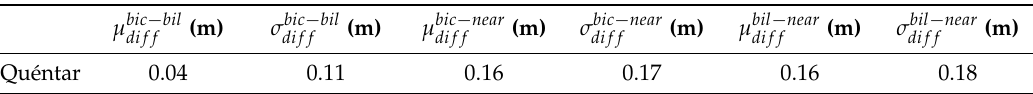
Table 4. Mean differences for PIVEHD modules and standard deviations comparing pairs of interpolation methods.